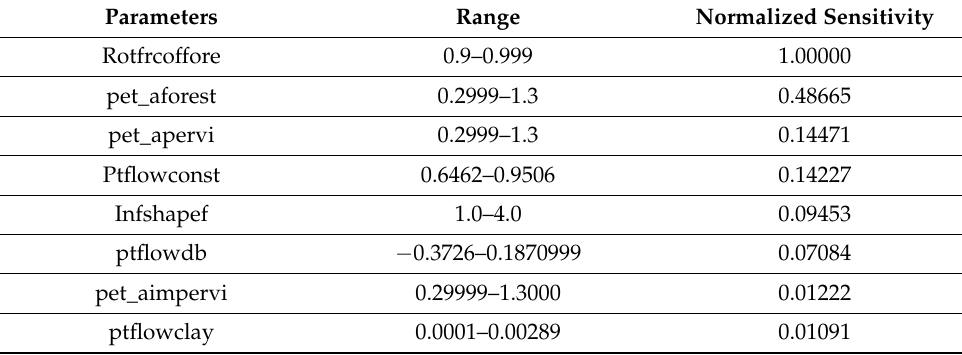
Table A2. Normalized sensitivity